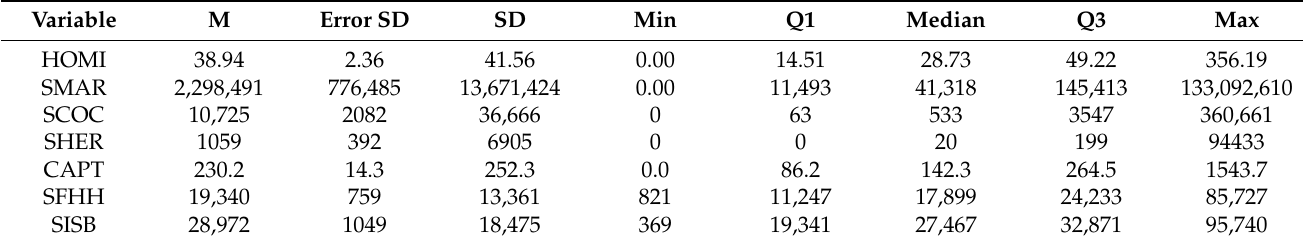
Table 2. Descriptive statistics (Pereira, 2010–2019).